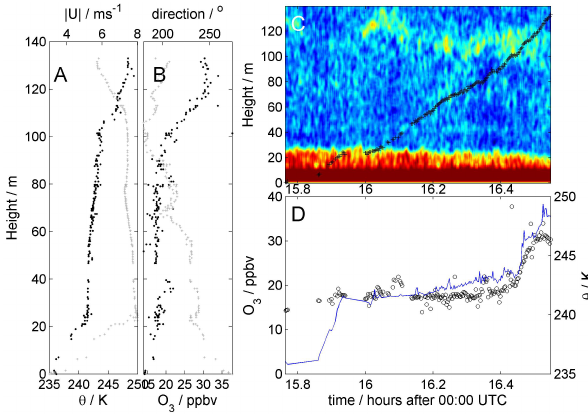
Fig. 8. As for Fig. 3 but now for the flight of 7 September 2007. Please note the difference in